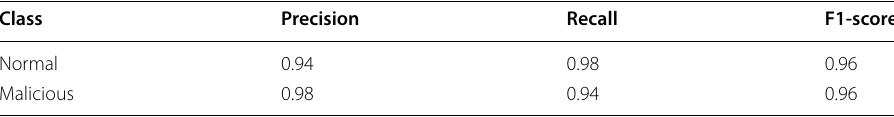
Table 11 Classification report of ANN